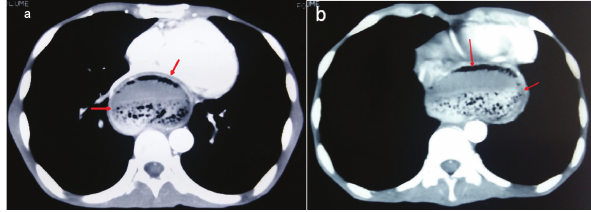
Figure 1. Contrast CT chest showing hugely dilated esophagus (11cm size), containing food residue (arrow) coursing from the right (a) to the left side (b) of the chest. and an empirical intravenous antibiotic. A nasogastric tube